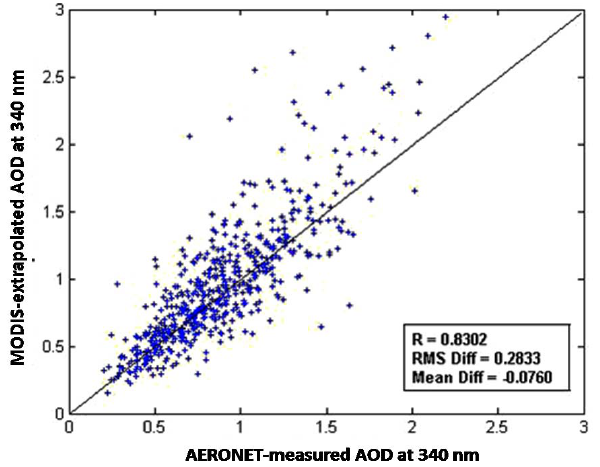
Fig. 2. The dependence of 1τ 340 on ε .